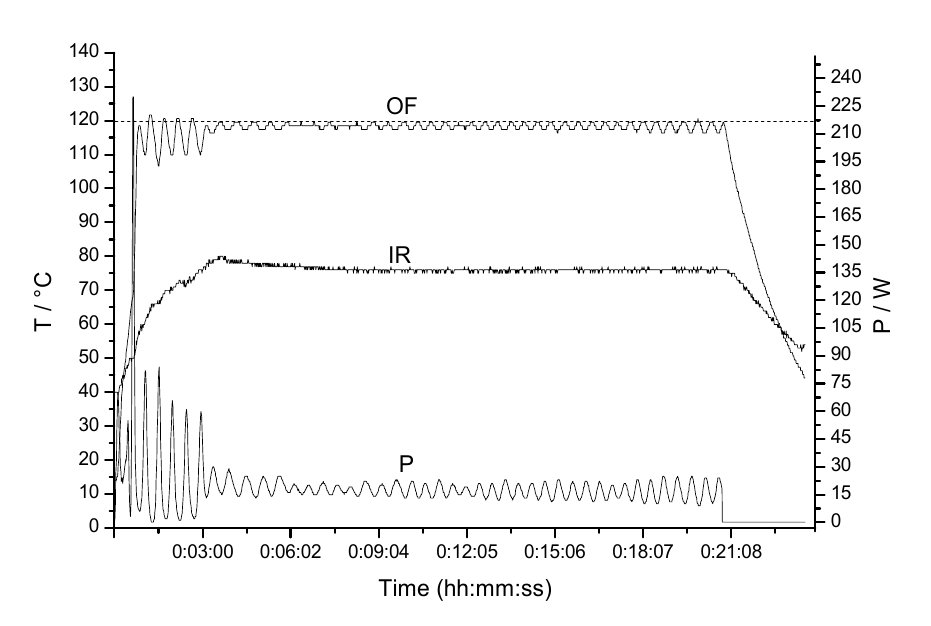
Figure 1. FO/IR temperature (T) and power (P) profiles for the reaction to obtain compound 3b